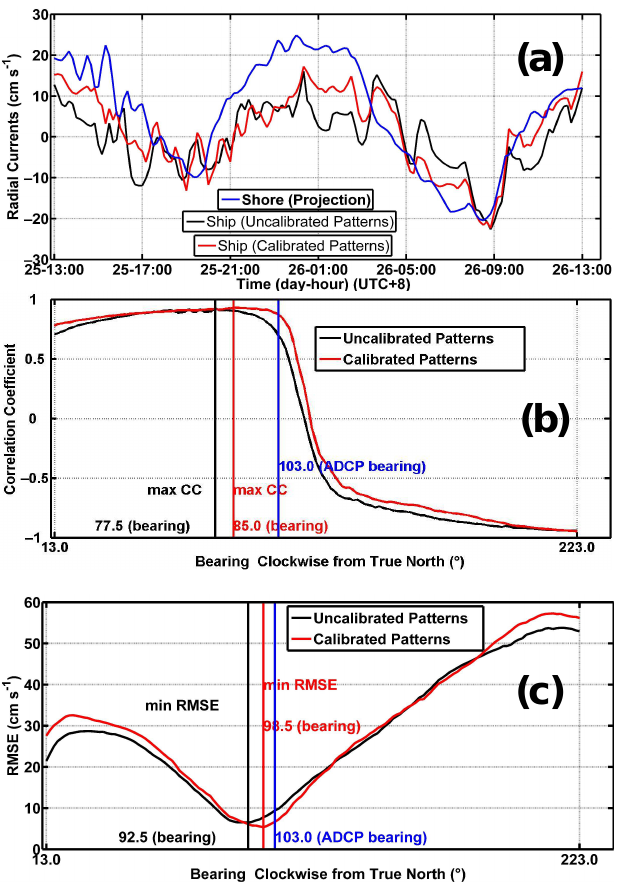
Figure 14. Point ‘B’ from 1300 UTC+8 25 December 2016 to 1300 UTC+8 26 December 2016: ( a ) radial currents detected by the ship radar site (using the uncalibrated (black line) and the calibrated patterns (red line)) compared with the radial projection (blue line) of total vector currents produced by the shore radar sites; ( b ) CCs at a fixed range passing through point ‘B’ before pattern corrections (black line) and after pattern corrections (red line); ( c ) RMSEs at a fixed range passing through point ‘B’ before pattern corrections (black line) and after pattern corrections (red